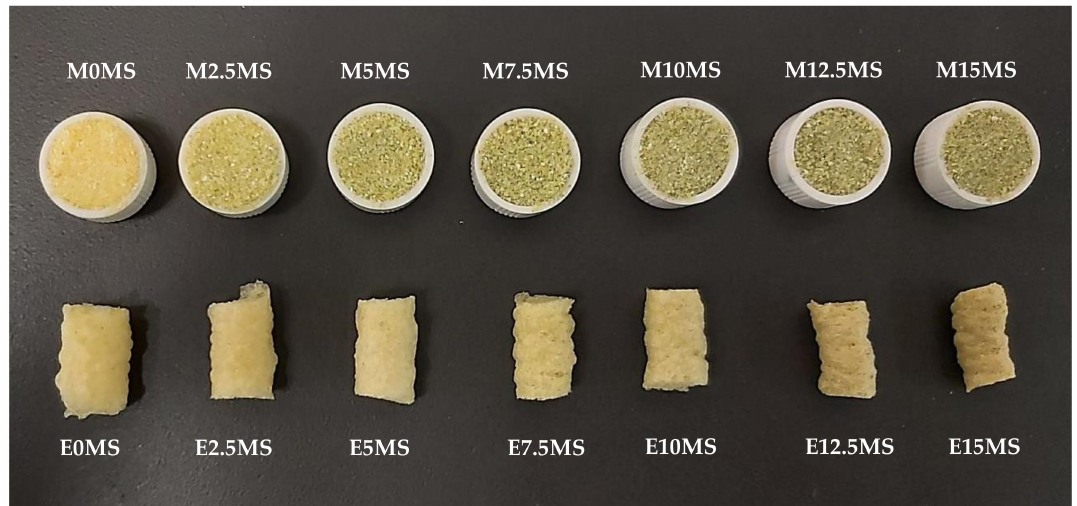
Figure 1. Appearance of studied mixtures (M) and extrudates (E), with different concentrations (0, 2.5, 5, 7.5, 10, 12.5, and 15%) of Medicago Sativa